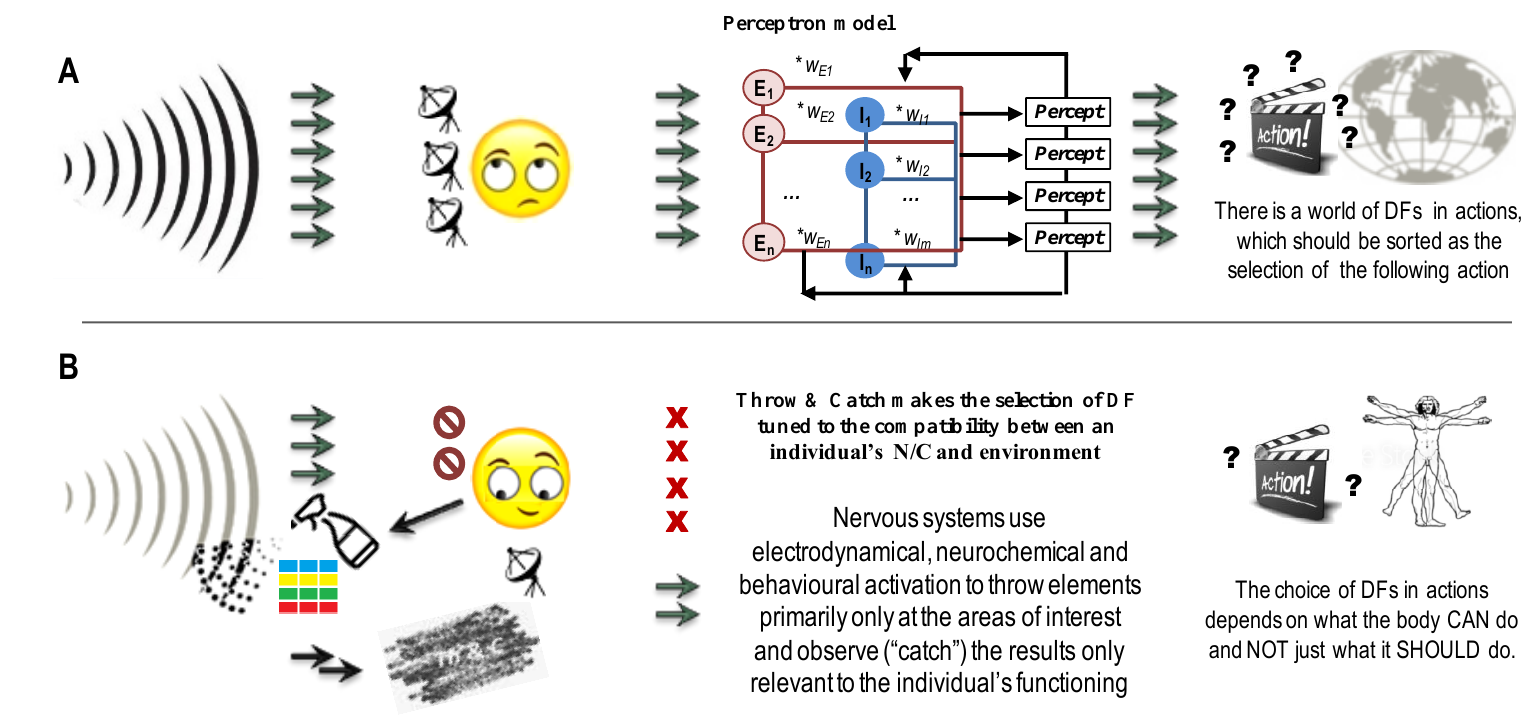
Figure 2. The contrast between the Perceptron and classic excitation-inhibition models ( A ) and the Throw & Catch (T&C) principle ( B ). ( A ): In common Perceptron-like models, perception is viewed as receptors (depicted as antennas) passively receiving and processing ALL surrounding information using sets of inhibitory and excitatory networks. Biases are given as weights added to the size of the signals. ( B ): In the T&C principle, the nervous system throws substances and actions towards relevant targets, similarly to a pencil technique looking for the dents on a paper sheet. The “Throw” processes proactively generate an additional variance to increase the visibility of details needed to select degrees of freedom. The “Catch” processes represent much more organized and complex parts of the nervous system compared to the “Throw” processes. The Catch systems use strategic placement of receptors (depicted as an antenna) to analyze the resulting “dents”. The directionality of “Throw” and the position of Catch follow the body- and experience-related biases. The coloured rectangular logo symbolizes the role of neurochemical systems in inducing these biases. Using T&C as a self-regulated “flashlight” to amplify the details of perceiving DFs allows nervous systems to save resources by not sensing the majority of surrounding stimuli and have a proactive search for the relevant information.